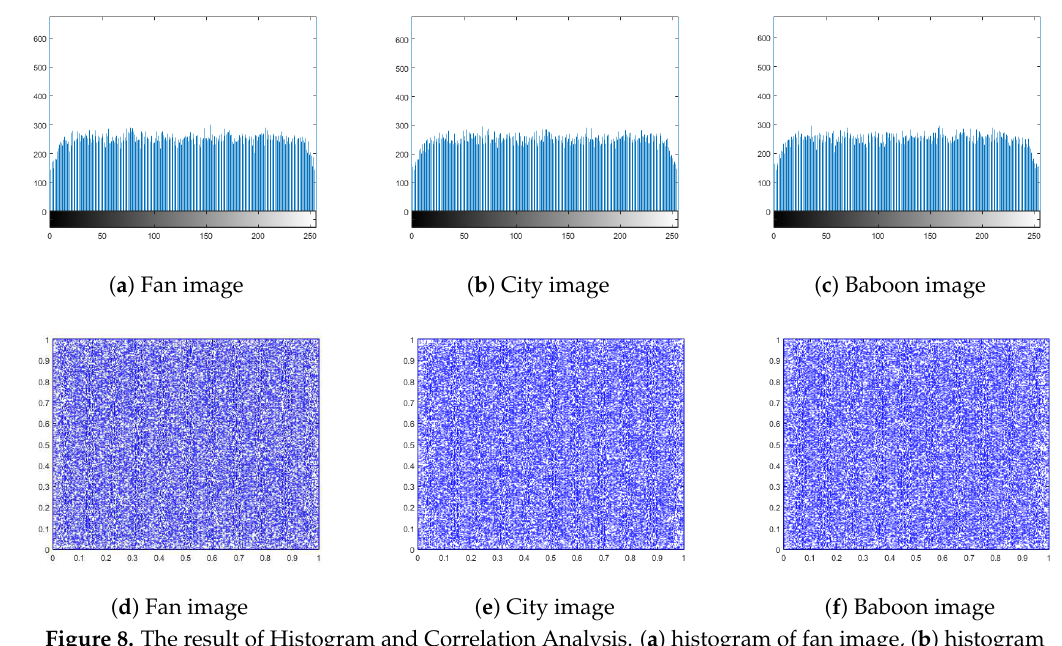
Figure 8. The result of Histogram and Correlation Analysis. ( a ) histogram of fan image, ( b ) histogram of city image, ( c ) histogram of baboon image, ( d ) correlation analysis of fan image, ( e ) correlation analysis of city image, ( f ) correlation analysis of baboon image. Table 5. The security and performance analysis